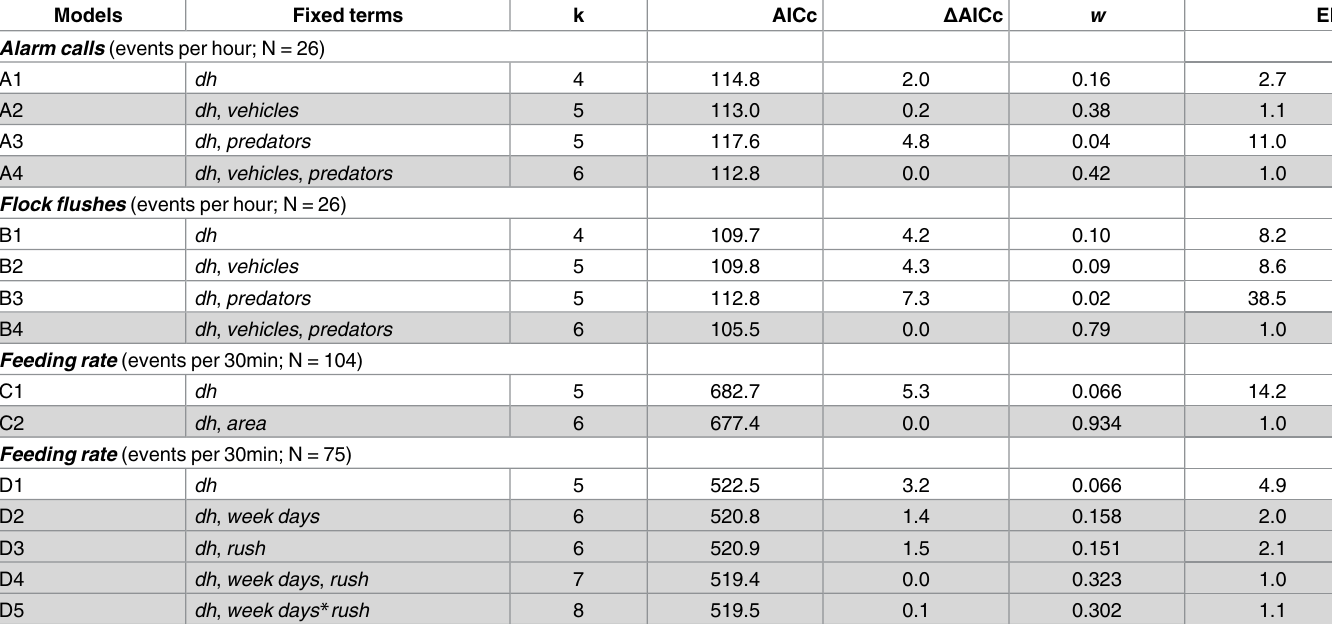
The last four columns show the parameters allowingselection of the best models within any given set. Smaller AICc values suggest a better fit of the model to data while penalizingfor complexity (k, number of estimated parameters). The best supported models ( Δ AICC < 2) are highlightedin grey. AICc weights ( w ) indicate the conditional probability of being the best supported model. Evidence Ratio (ER) is the ratio of w , comparing the best supported model with every competing one. Legend: dh = date and hour; area (2-level factor: traffic-exposed vs . traffic-free); week days (2-level factor: workdays vs . weekends); rush (2-level factor: rush-hours vs .